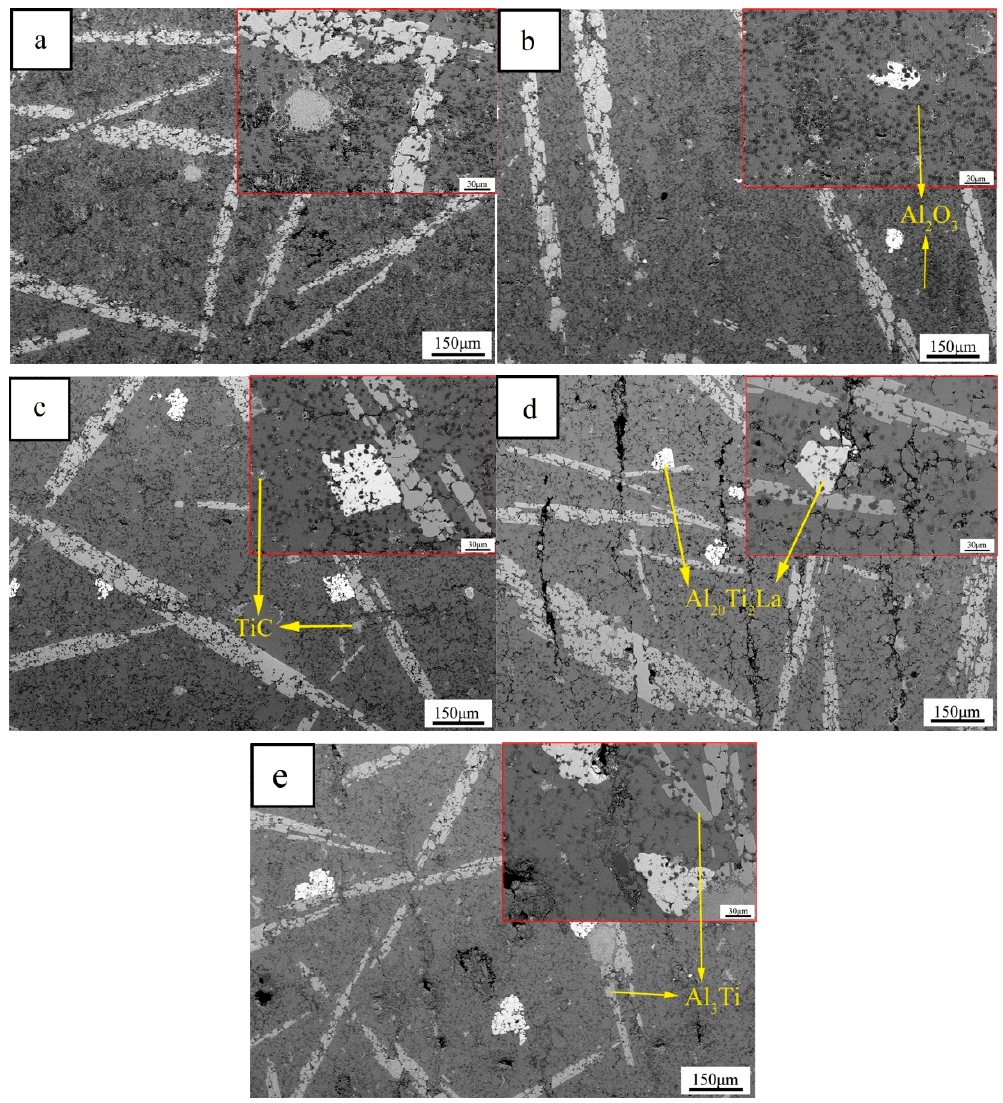
Figure 4. Microstructure of Al-TiO 2 -C-XLa 2 O 3 . ( a ) X = 0; ( b ) X = 0.1; ( c ) X = 0.2; ( d ) X = 0.3; ( e ) X = 0.4.